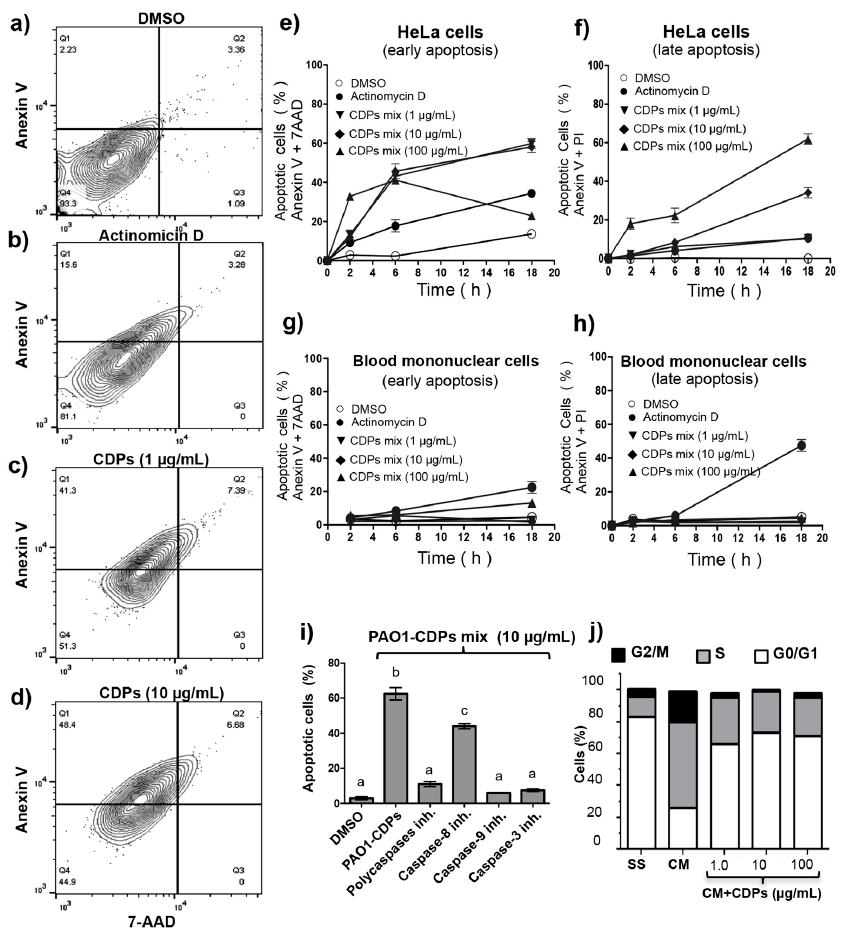
Figure 3. Apoptosis induction in HeLa cells by CDPs from P. aeruginosa PAO1 . HeLa cells were incubated in the CM medium after treatment with PAO1-CDPs (various doses) as a function of time. Cells were stained with annexin V, 7-AAD, or propidium iodide and analyzed by flow cytometry. ( a – d ) The percentage of fluorescent cells determined in the dot plots is shown, corresponding to HeLa cells treated for 6 h with ( a ) DMSO; ( b ) actinomycin D (50 mg/mL), ( c ) PAO1-CDP mixture (1 μ g/mL); ( d ) PAO1-CDP mixture (10 μ g/mL). Q1, early apoptosis; Q2, late apoptosis; Q3, necrotic cells; Q4, viable cells; ( e , f ) Kinetic of induction early and late apoptosis stages in HeLa cells treated with the PAO1-CDP mixture; ( g , h ) Kinetics of induction of early and late apoptosis stages in blood mononuclear human cells treated with the PAO1-CDP mixture. Points of the plots represent mean ± standard error (SE) of three independent experiments; ( i ) Effects of inhibitors of apoptosis on HeLa cells in the presence of the PAO1-CDP mixture . The cells were incubated in the CM medium after treatment with 10 μ g/mL PAO1-CDP mixture with the addition of caspases inhibitors. Cells were revealed with annexin V and analyzed by flow cytometry. The percentage of fluorescent cells (apoptotic cells) after each treatment was determined by means of the dot plots and is shown as bars in the graph. The inhibitors tested are indicated on the X-axis. Bars of the plots represent mean ± SE of three independent experiments, n = 3. One-way ANOVA was carried out, with Tukey’s post hoc test; statistical significance ( p < 0.01) of differences between treatments is showed with different lowercase letters; ( j ) Effects of the PAO1-CDP mixture on the cell cycle in HeLa cells. HeLa cells were incubated in serum-free medium (SS) and serum-enriched medium (CM) after treatment with various doses of the PAO1-CDPs for 24 h. Cells were fixed with paraformaldehyde (4%) for 10 min on ice. Then, the cells were incubated with DAPI (1:1000) for 10 min at room temperature and analyzed by flow cytometry for DNA quantitation.